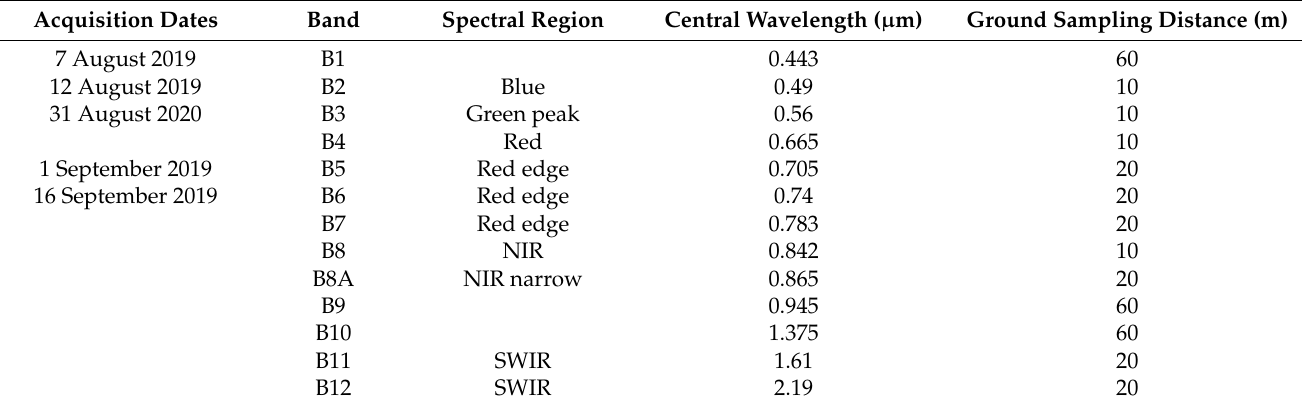
Table 2. Acquisition dates of Sentinel-2 satellite images and characteristics of spectral bands used in the study